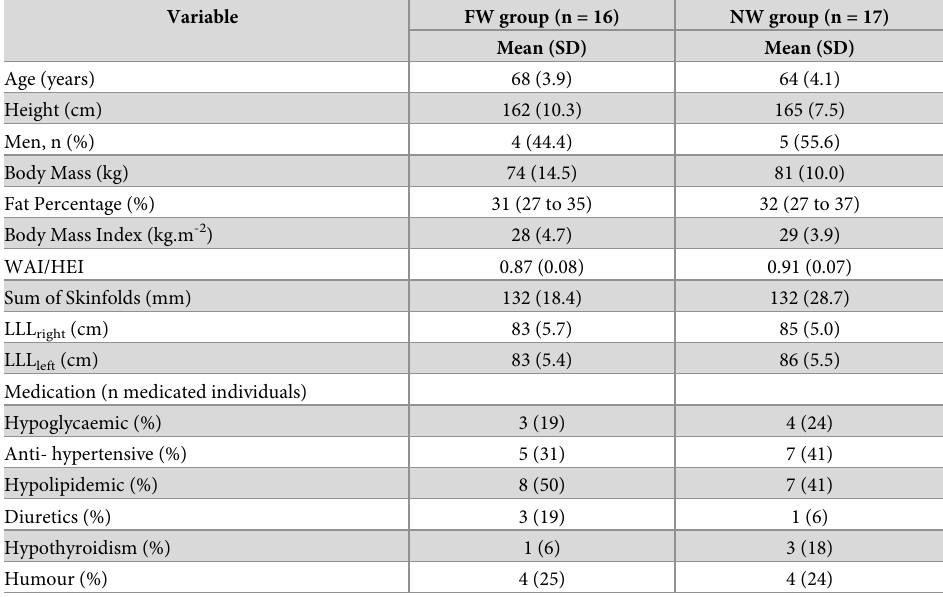
Table 1. Sample characterization. Mean and confidence interval (95% CI) for age, height, body mass, body mass index, waist/height ratio (WAI/HEI), sum of skinfolds, lower limb length (LLL), and